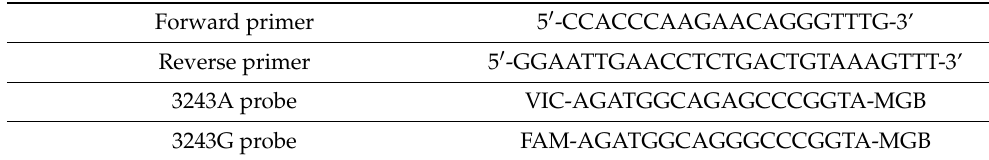
Table A3. Taqman primers and probes used for the determination of the m.3243A>G mutation